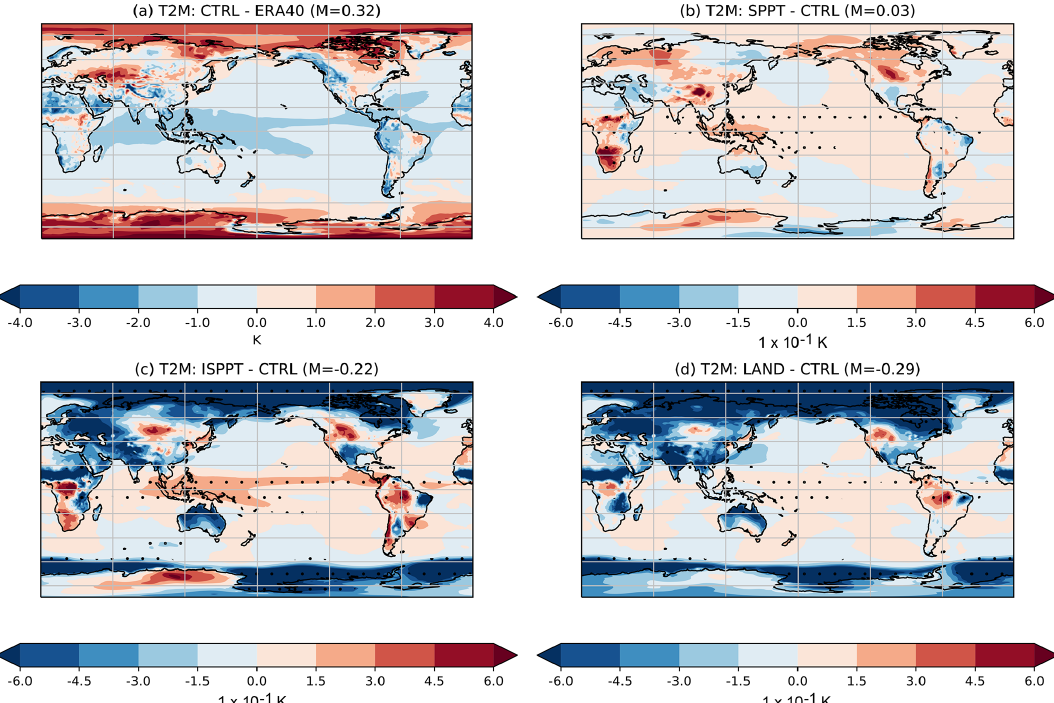
Figure 5. Mean differences in 2m temperature between (a) CTRL and ERA40, (b) SPPT and CTRL, (c) ISPPT and CTRL, and (d) LAND and CTRL. Stippling indicates regions where the difference is statistically significant to the 95% confidence interval, as measured by a two-tailed t test. In each panel, M denotes the mean of the difference. Note the difference in the scales between (a) and (b, c, d)